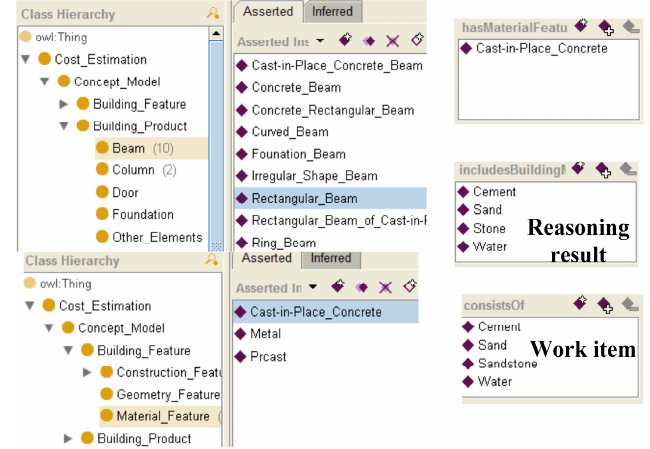
Figure 13. Reasoning result of the beam ‐ related building material.